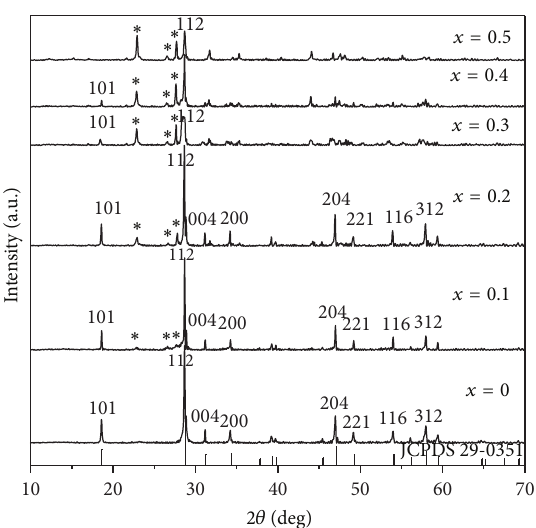
Figure 1: XRD patterns for (Ca 1−𝑥 , La 𝑥 )MoO 4 :Eu 3+ (5mol%) ( 𝑥 = 0 , 0.1, 0.2, 0.3, 0.4, and 0.5) phosphors.